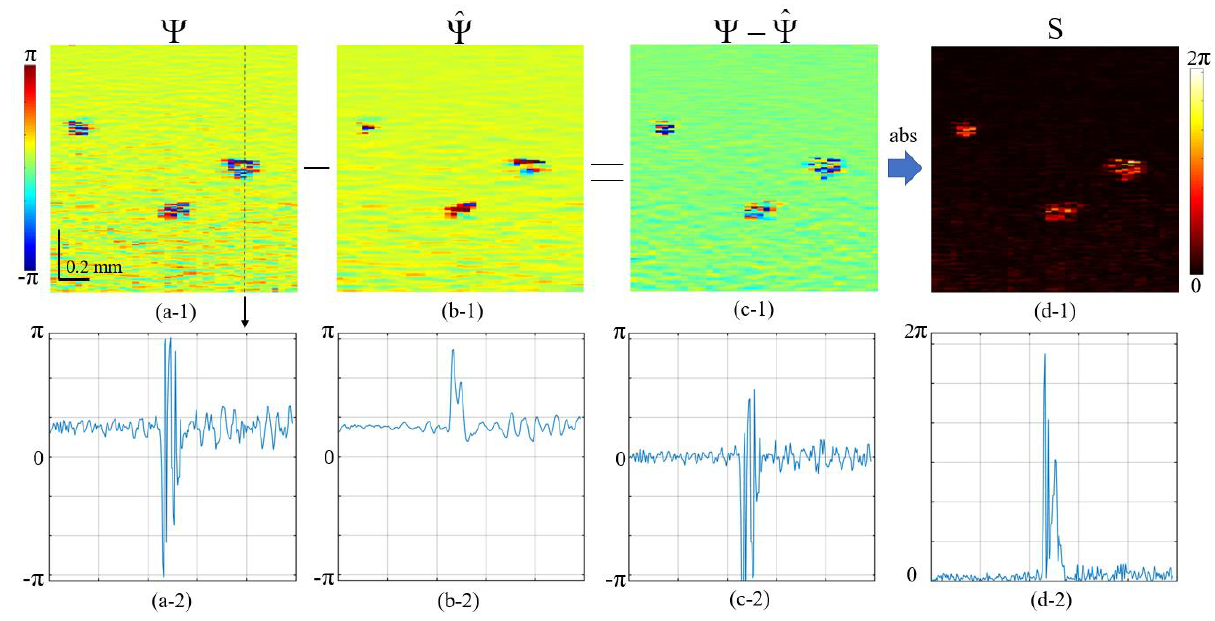
Figure 6. Illustration of OCA-S signal processing based on Equation (6). Upper row—2D images; lower row—1D profiles, corresponding to A-scan that passes through one of the vessels as marked by the dashed line on a panel ( a-1 ). Ψ —axial phase gradient, ˆ Ψ —vector averaged phase gradient. Both quantities have a non-zero average value proportional to the interframe strain, which is removed by subtraction of Ψ and ˆ Ψ (panel ( c-1 )). It is necessary to take the absolute value (shown in panel ( d-1 )) for further averaging for several overlapping S-scans, because, otherwise, averaging of alternating sign values inside the vessels results in a signal decrease down to zero mean value. In the final S image, there are three clearly visible blood vessels that appear as noise regions on a low signal background. The scale bar is 0.2 mm .